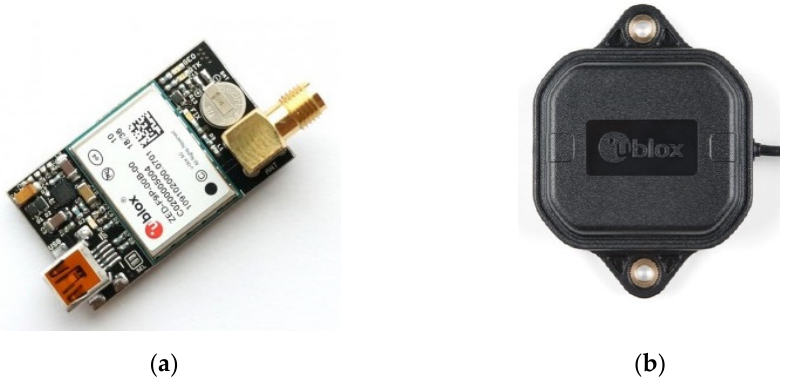
Figure 3. Equipment used: ( a ) low-cost GNSS receiver; ( b ) U-Blox antenna.